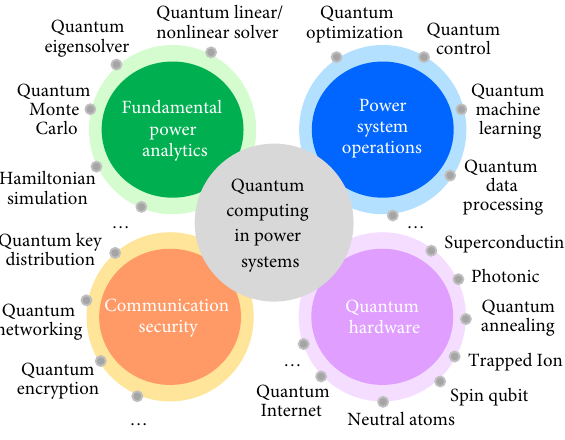
Fig. 1 A schematic of quantum computing for power